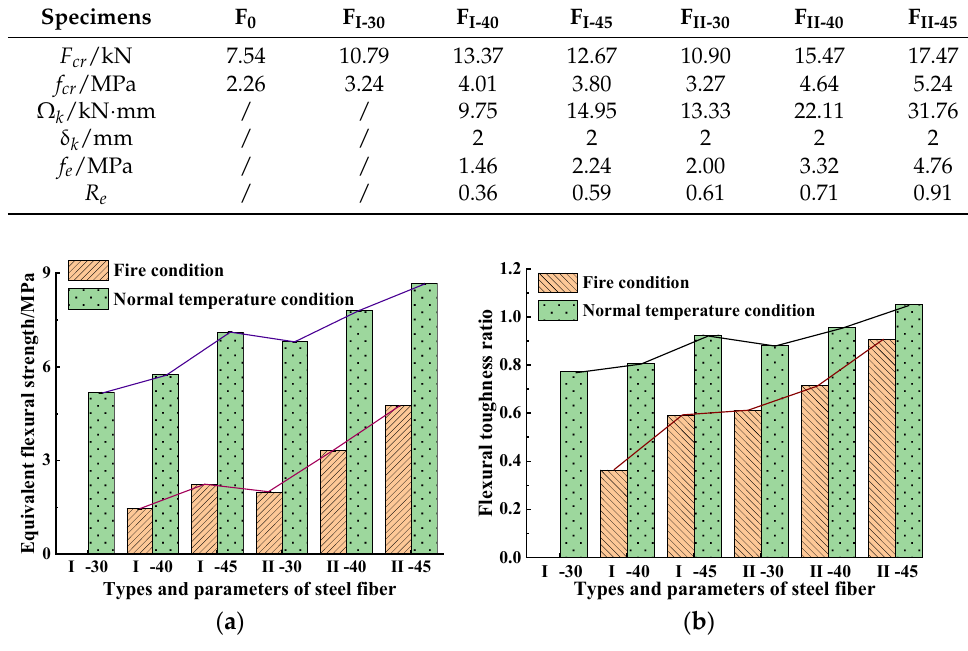
Figure 12. Comparison results of the equivalent flexural strength and flexural toughness ratio of specimens before and after high temperature: ( a ) equivalent flexural strength; ( b ) flexural toughness ratio.